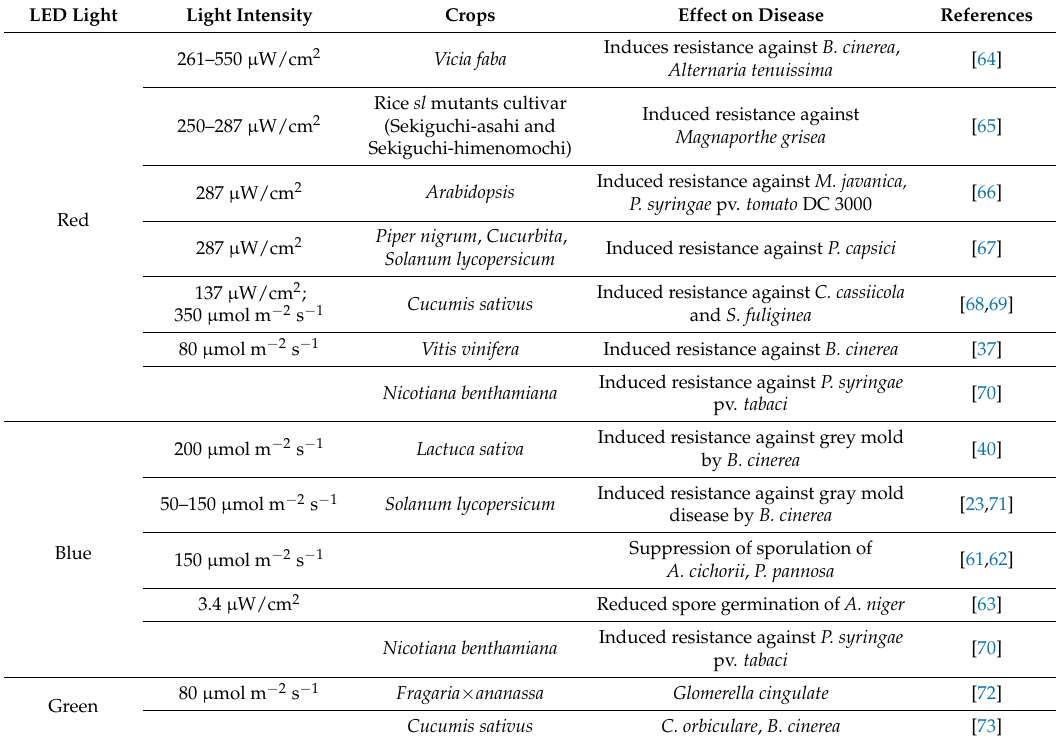
Table 2. Induced disease resistance in crops treated with different light from